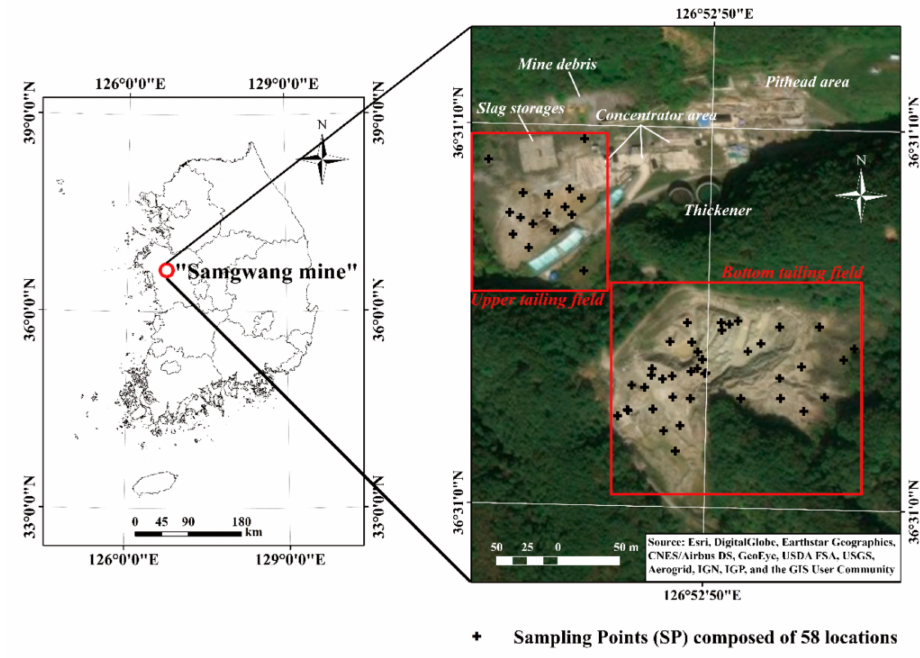
Figure 1. Location map of Samgwang mine ( left ), and distribution of mining facilities, tailing areas, and sampling locations (SP01–SP58) in Esri World Imagery Map (available at http://goto.arcgisonline. com/maps/World_Imagery) ( right